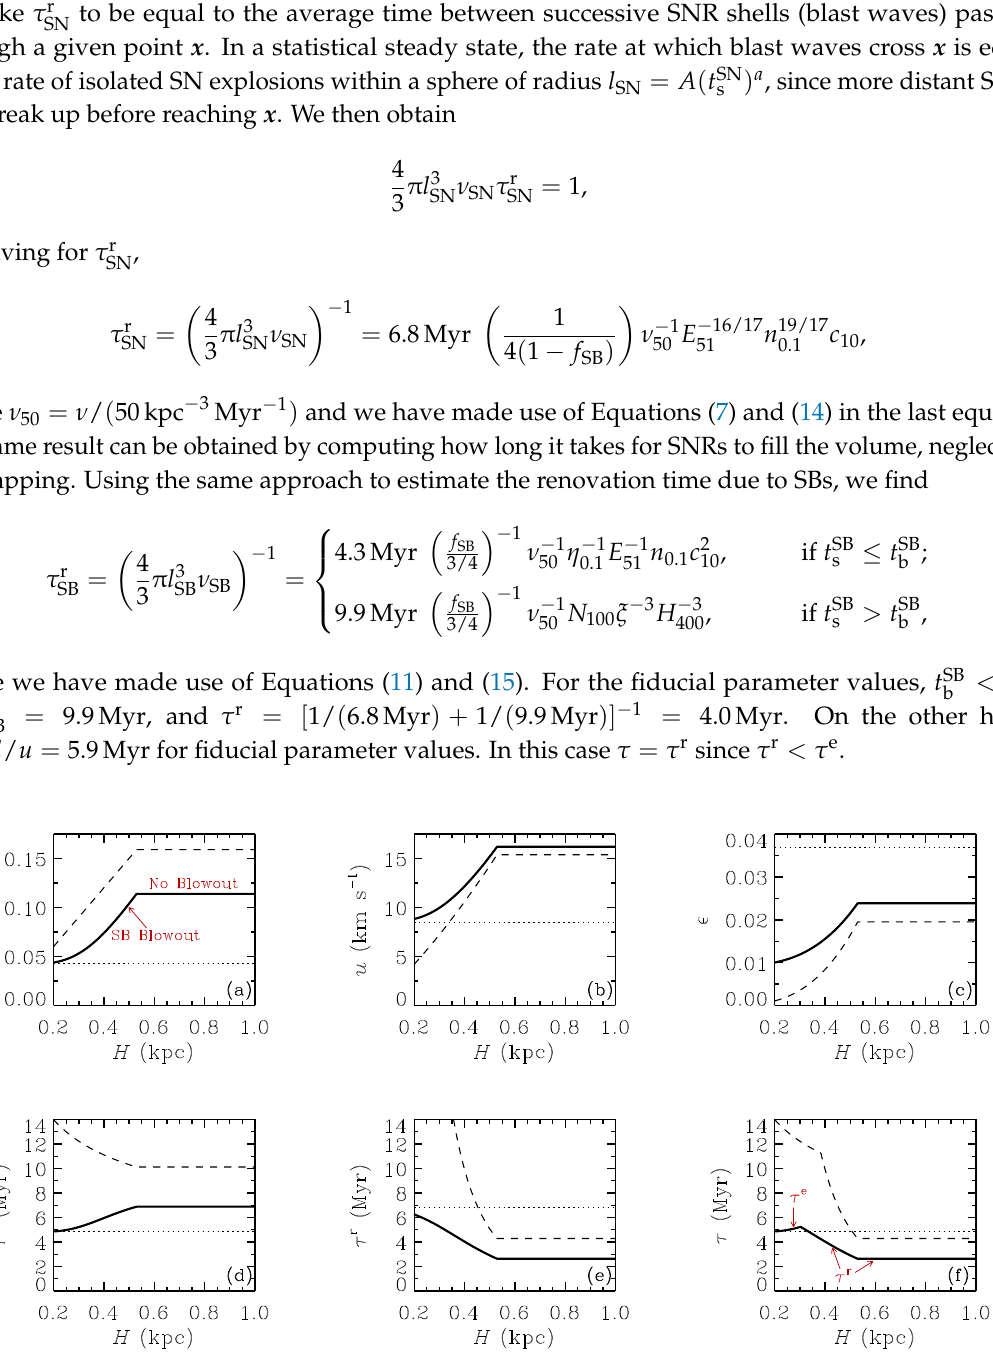
Figure 2. Results for the fiducial parameter values of Table 1 ( n = 0.1cm − 3 , c s = 10kms − 1 , ν = 50kpc − 3 Myr − 1 , N SB = 100, η = 0.1 and C = 3/4) plotted against gas scale height H (fiducial values quoted in the text assume H = 0.4kpc). Dashed curves show the solution obtained if only the SB component is included, dotted lines show the solution obtained if only the isolated SN component is included (whose evolution is independent of H in the model), and solid curves show the solution obtained by including both SB and isolated SN